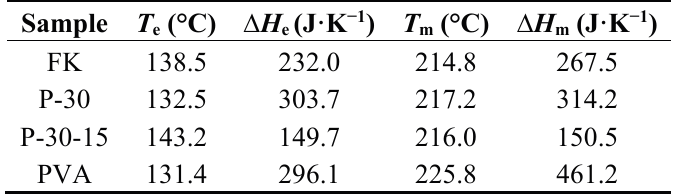
Figure 3. Comparison of the DSC curves obtained for pure FK, P-30, P-30-15, and pure PVA, respectively. Table 1. Temperatures (°C) and enthalpy values (J·K − 1 ) corresponding to the endothermic peaks observed for the different FK